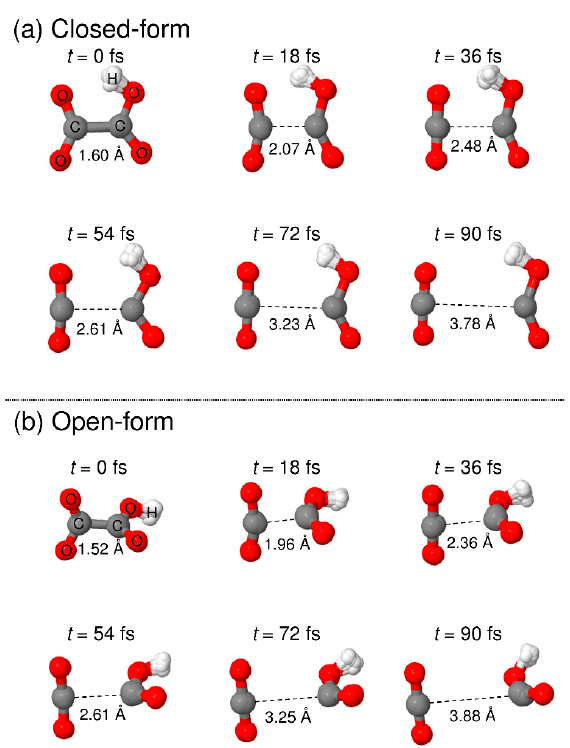
Figure 6. Snapshots of typical RPMD trajectories calculated starting from the ( a ) closed-form and ( b ) open-form C 2 O 4 H − isomers.